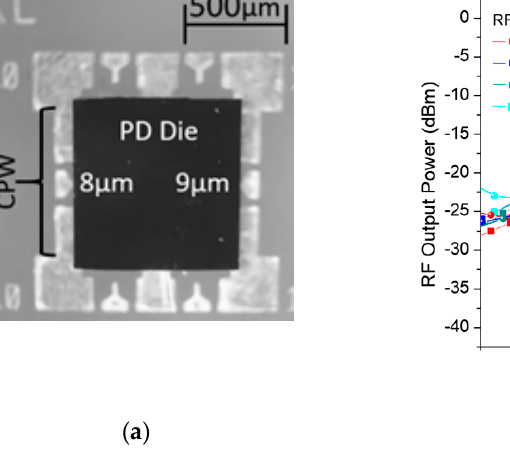
Figure 1. ( a ) Photodiode (PD) die on submount after flip-chip bonding. ( b ) Radio frequency (RF) output power and compression at 160 GHz of modified uni-traveling carrier photodiodes (MUTC-PDs) with different diameters.